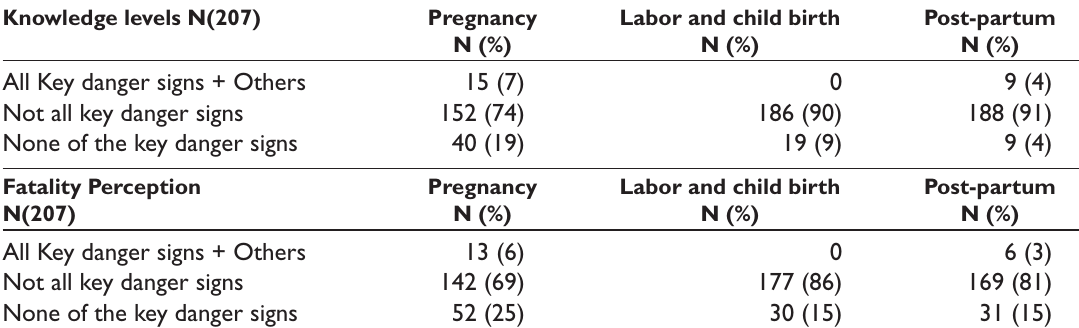
Distribution of Knowledge of danger signs during Pregnancy, Labor and child birth and Post- partum periods for the ASHAs, Primary Survey, 2011